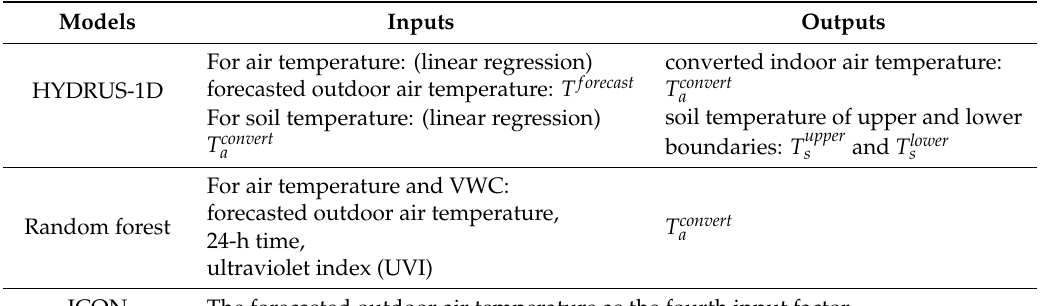
Table 3. Inputs and outputs for converting the forecasted outdoor air temperature to the indoor air temperature for the studied